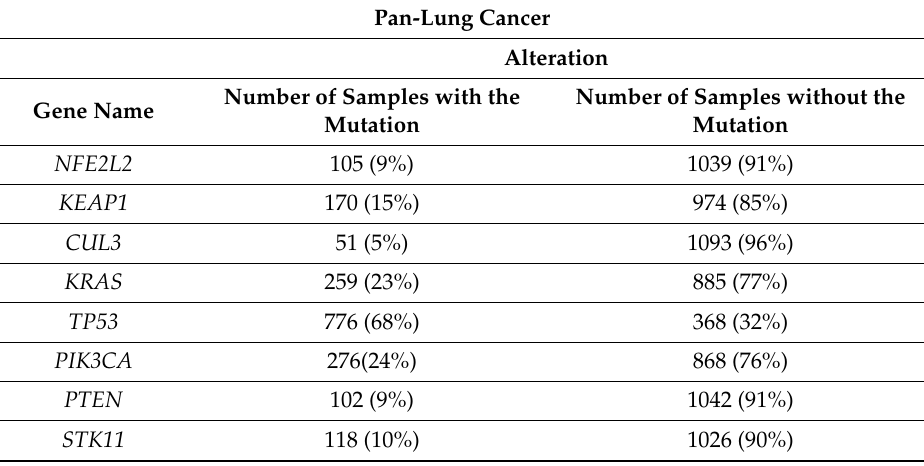
Table 3. Mutations in genes implicated in regulating NRF2 activity in NSCLC